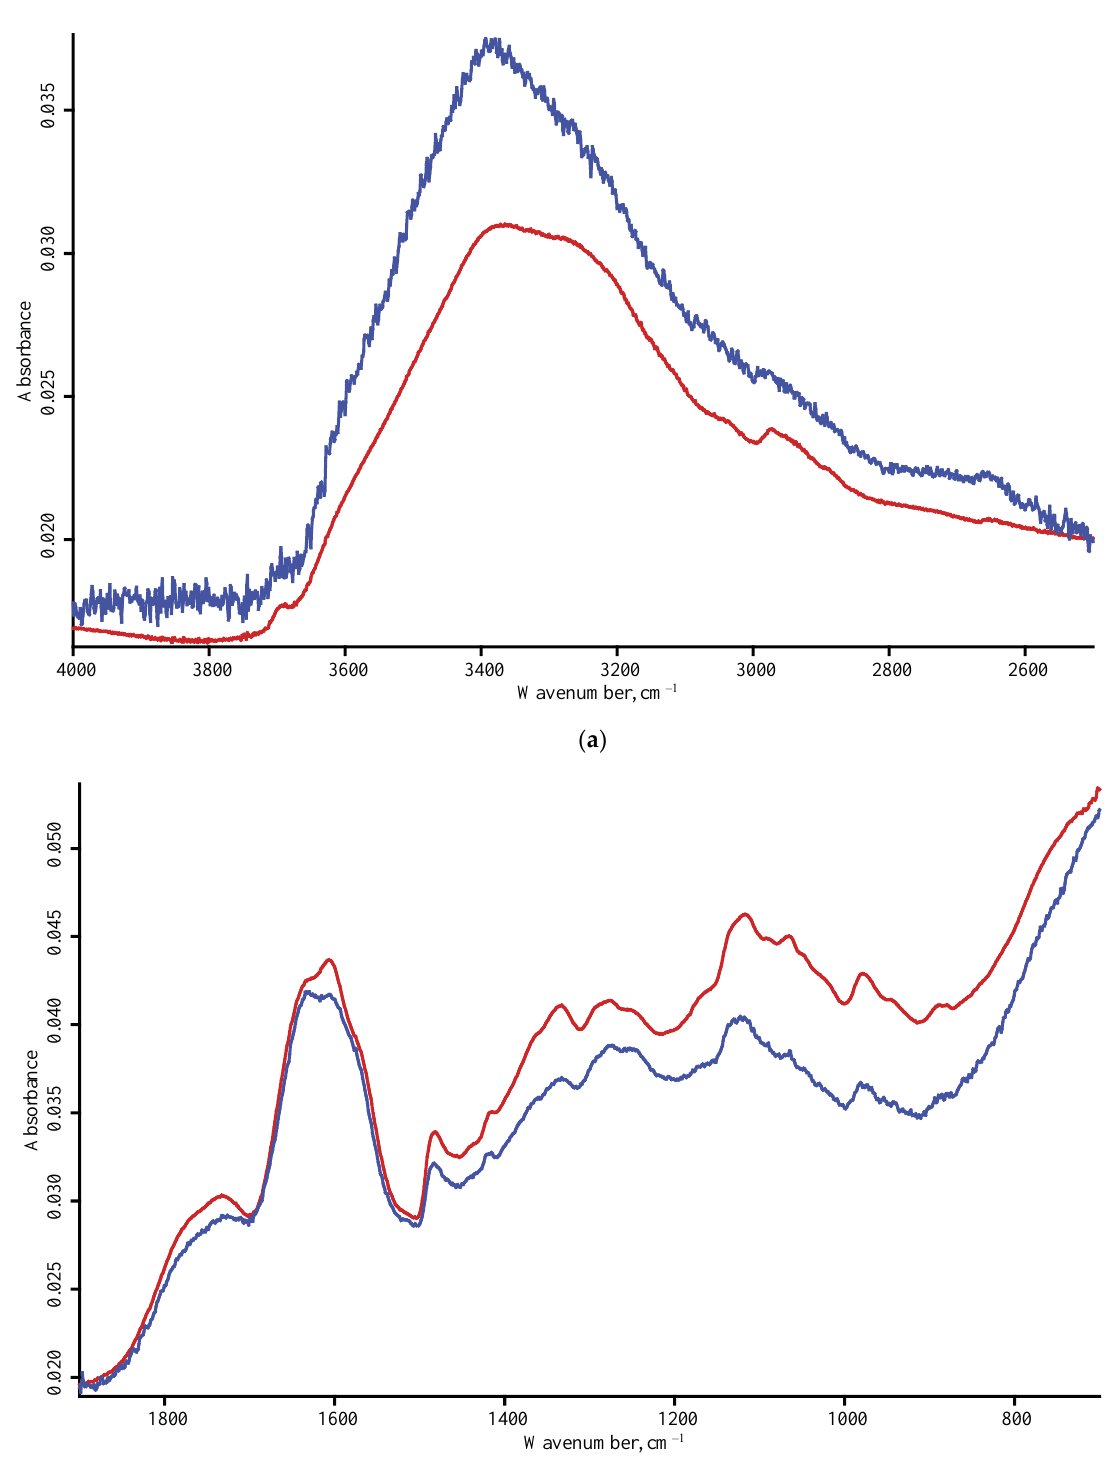
Figure 10. ATR mode, PL-D-G-01P nanodiamonds; red, LN-MCT photovoltaic detector; blue, DLaTGS detector; ( a ) 4000–2500 cm −1 , ( b ) 2000–800 cm −1 range. Spectra were not smoothed but normalized to maximize each spectrum.